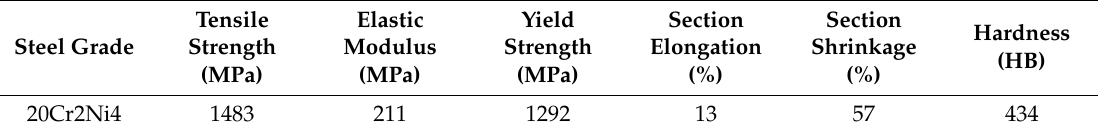
Table 2. Mechanical properties of